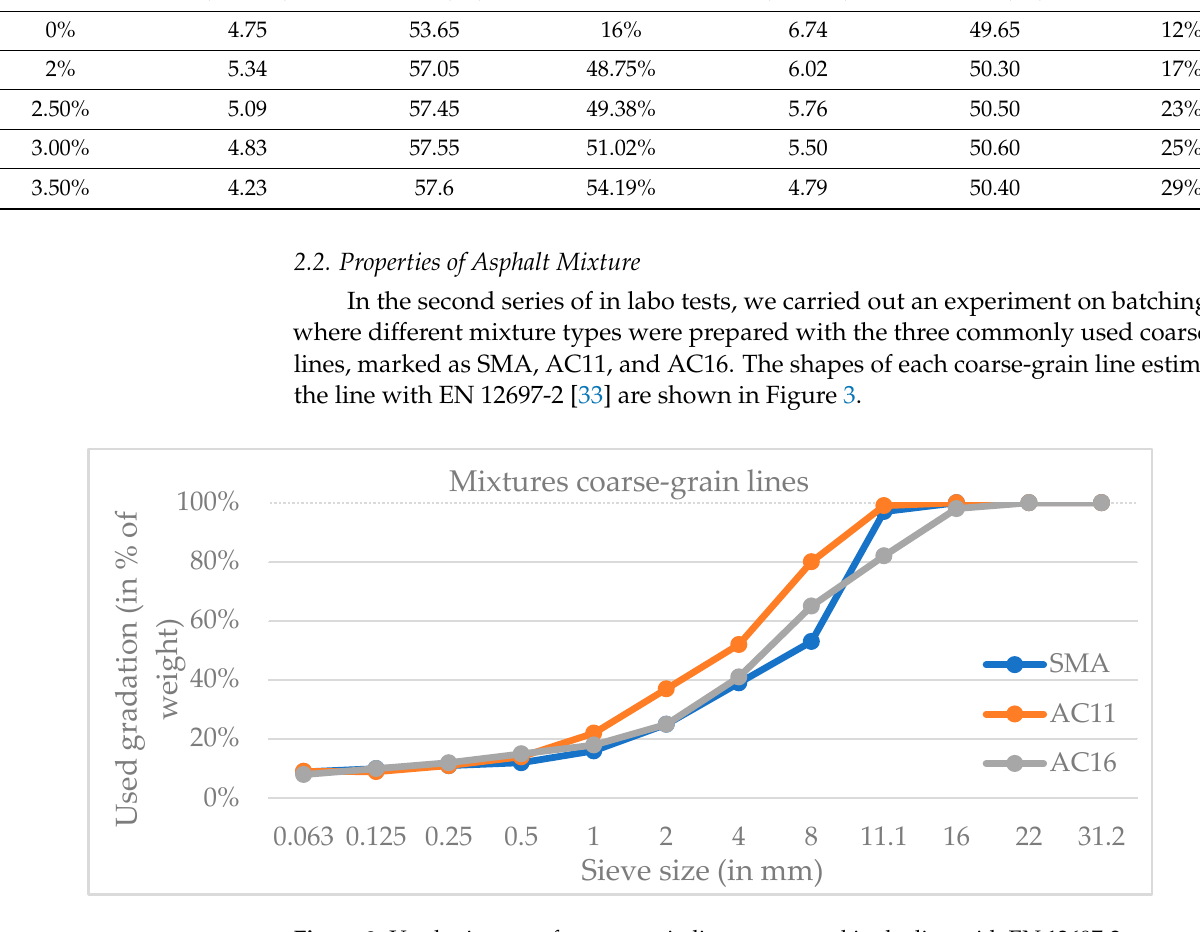
Figure 3. Used mixtures of coarse-grain lines, measured in the line with EN 12697-2. For each type of coarse-grain line used, comparison mixtures with other types